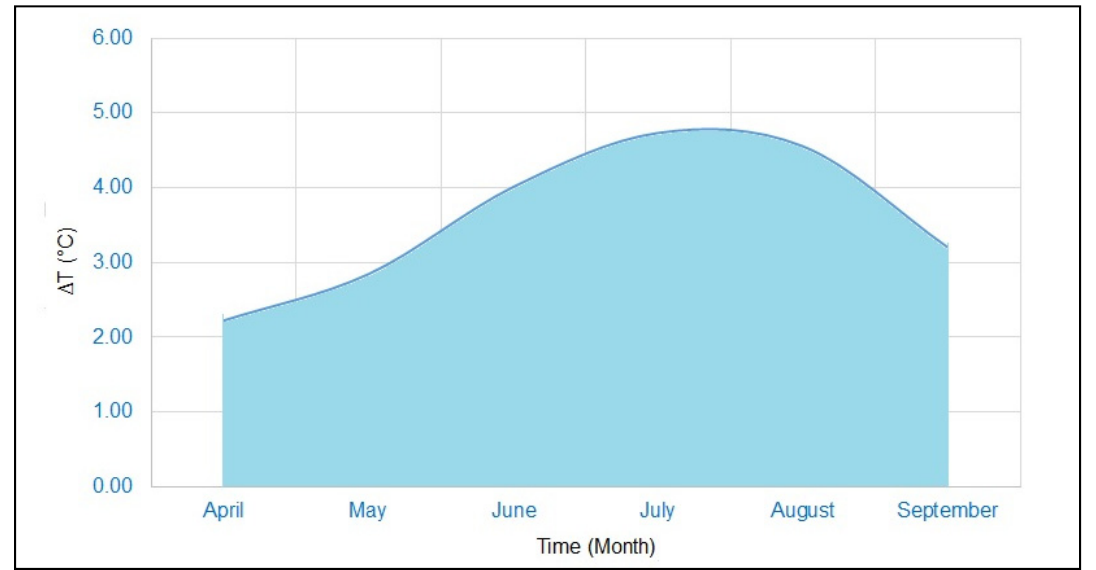
Figure 7. Thermal comfort requirement in a hot dry climate